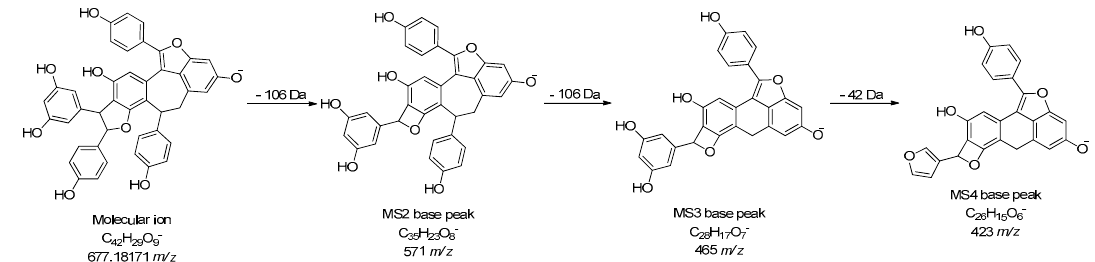
Figure 2. Proposed fragmentation pathway of compound 26 .